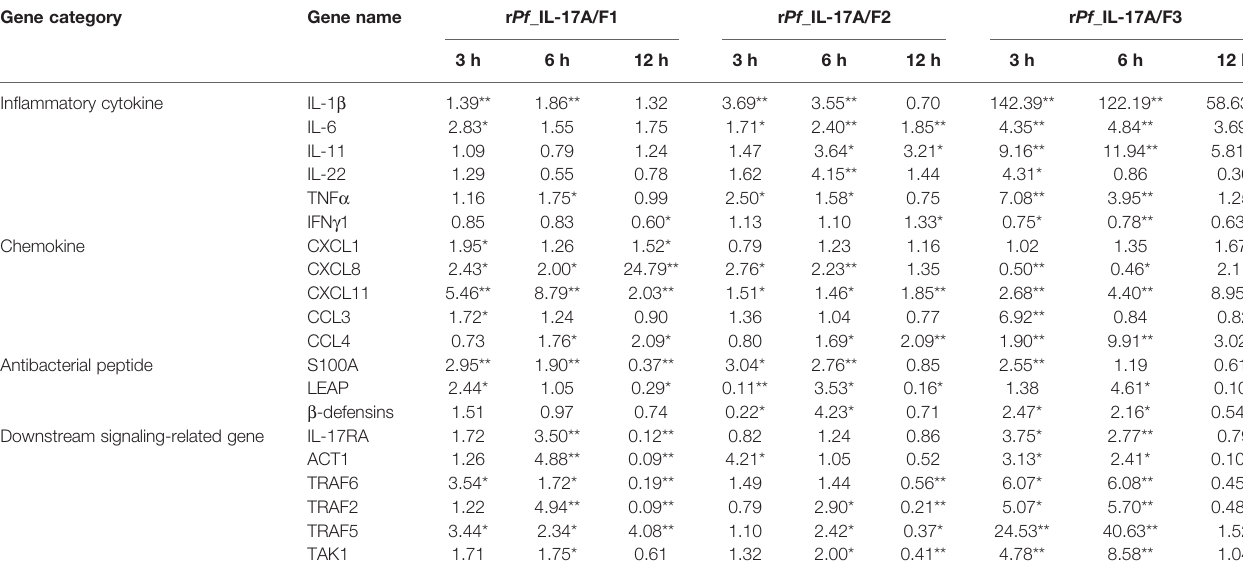
TABLE 1 | Transcriptional fold changes of in fl ammatory cytokines, chemokines, antibacterial peptides and downstream signaling-related genes in yellow cat fi sh PBLs after treatment with the r Pf _IL-17A/F1, 2 and 3 proteins (500 ng/mL) for 3 h, 6 h and 12 h. Gene category